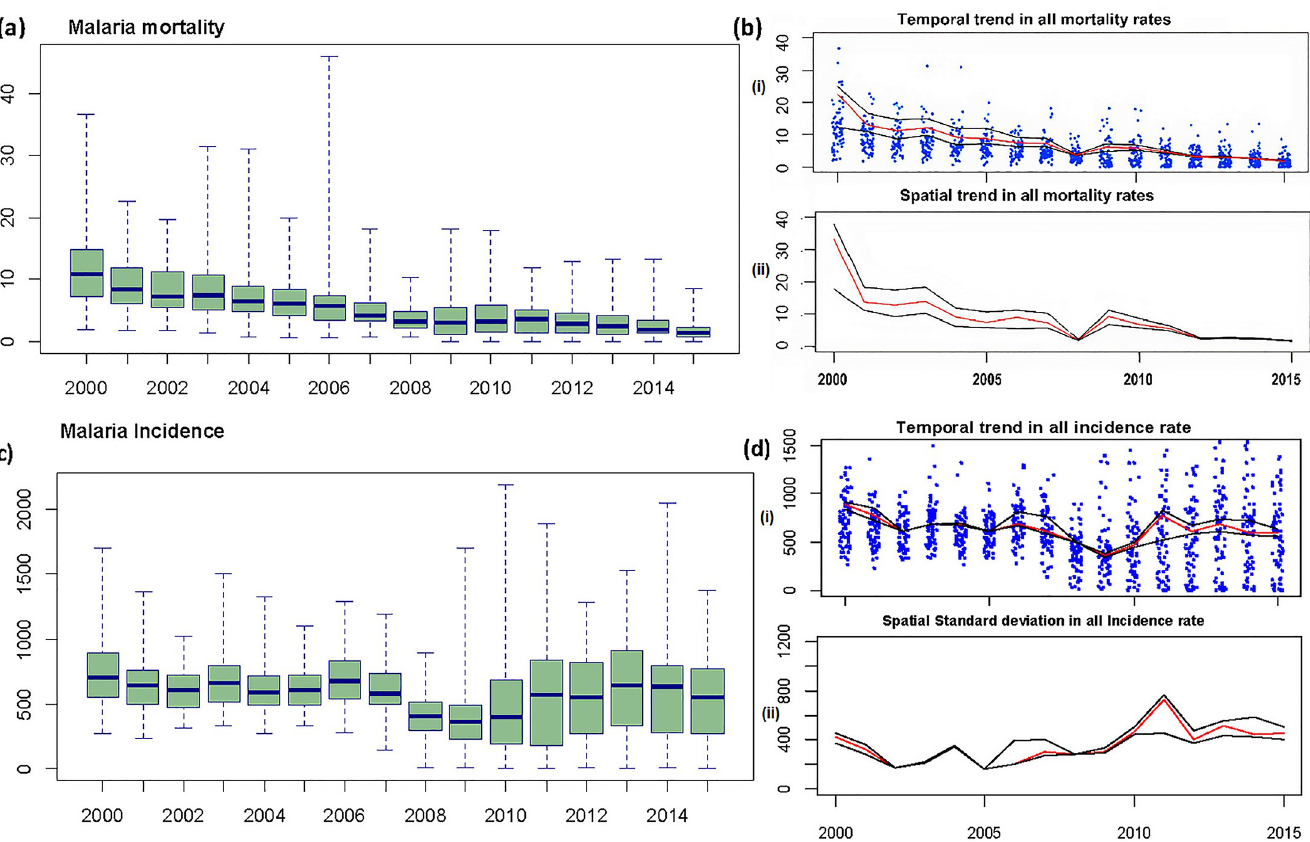
Fig 2. Box plots vs spatio-temporal trends and deviations in transmission. (a & c) are box plots showing temporal mean and inter-quartile ranges of all age malaria mortality and incidence from 2000–2015. (b&d) show the temporal and spatial standard deviations in mortality and incidence rates (Posterior median (red); 95% credible interval (black); each blue dot representing the mortality/incidence rate for each district and year). Temporal mortality decline is associated with increasing spatial homogeneity (a & b), while the incidence trend is more temporally and spatially heterogeneous over the same period. (c &